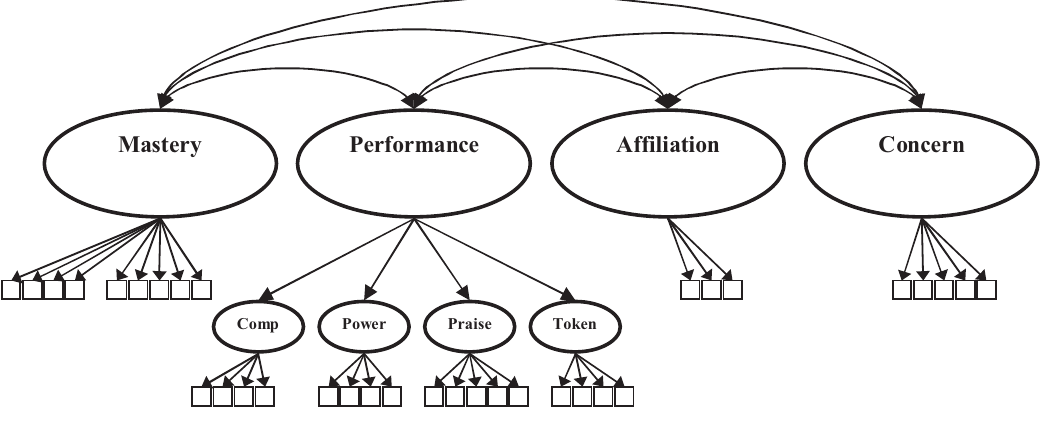
.97, and the TLI from .94 to .96. Factor loadings (Table